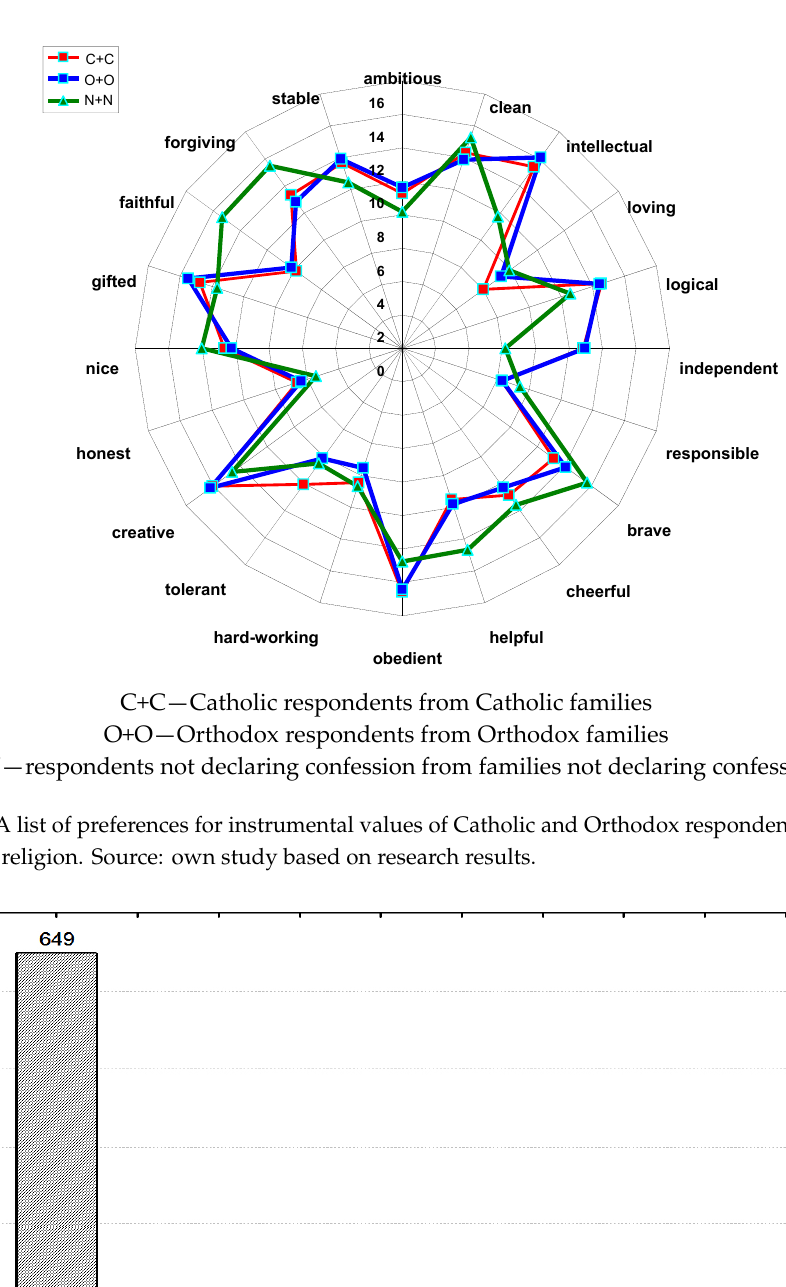
Figure 9. A list of terminal value preferences of Catholic and Orthodox respondents who do not declare any religion. Source: own study based on research results.